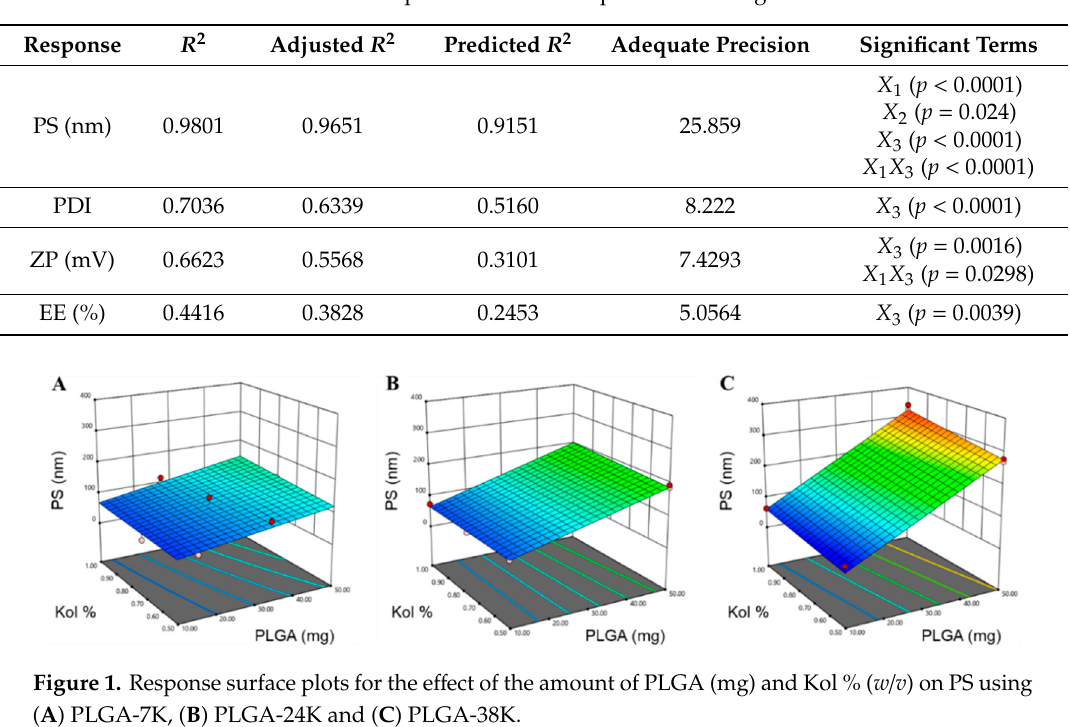
Table 3. Output results of the experimental design.